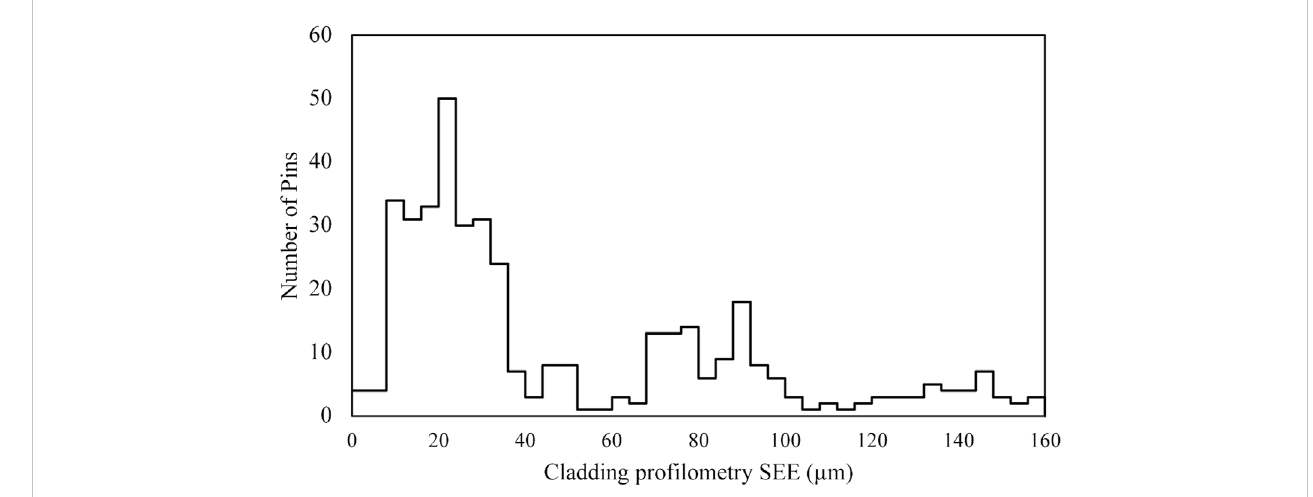
Cladding pro fi lometry Standard Error of the Estimate values.